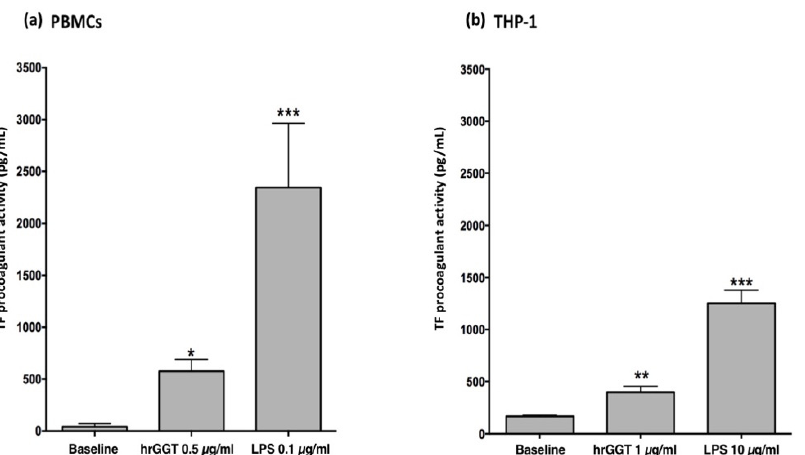
Figure 1. ( a ) TF procoagulant activities measured in PBMCs stimulated by hrGGT (0.5 µ g/mL) and LPS (0.1 µ g/mL). ( b ) TF activity measured in THP-1 cells stimulated by hrGGT (1 µ g/mL) and LPS (10 µ g/mL). Data are presented as means ± SEM ( n = 10). * p < 0.05 vs. the baseline; ** p < 0.01 vs. the baseline; *** p < 0.001 vs. the